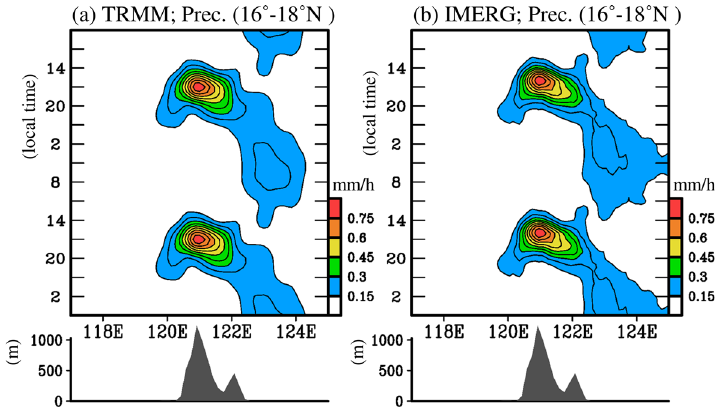
Figure 4. Longitude (x-axis) versus time (y-axis) diagram of climatological diurnal evolution of precipitation averaged over 16–18°N for spring during 2001–2019: ( a ) TRMM and ( b ) IMERG. The times are given in local time. The altitude of topography averaged over 16–18°N is given in the bottom panel to help the discussion. This figure is created using the software of GrADS